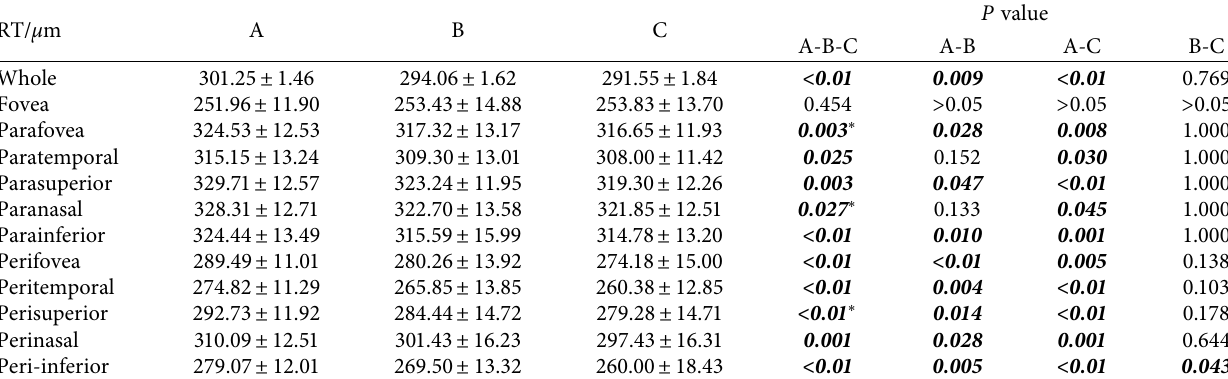
Table 5: RT of full retina in the three diagnostic